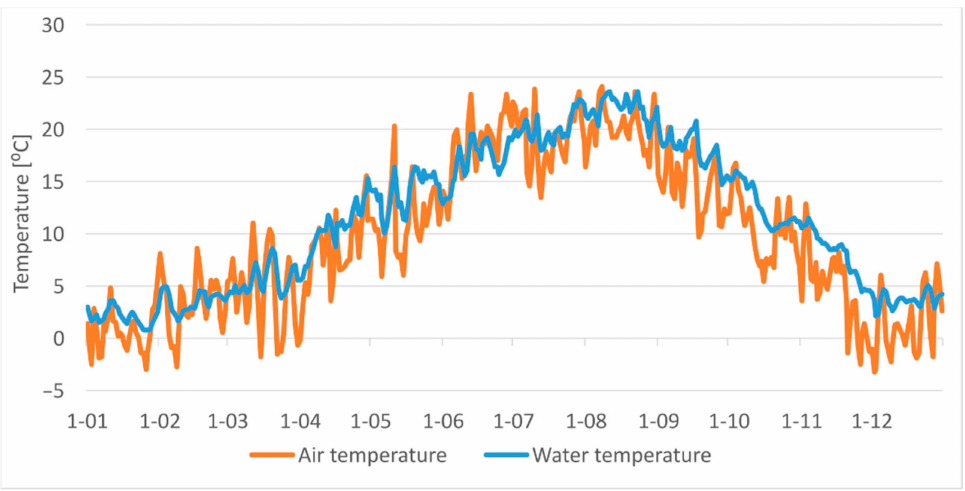
Figure 19. Water temperature diagram in the Wisła River (Szczucin) with the minimum, average, and maximum daily power generated in the Połaniec power plant.